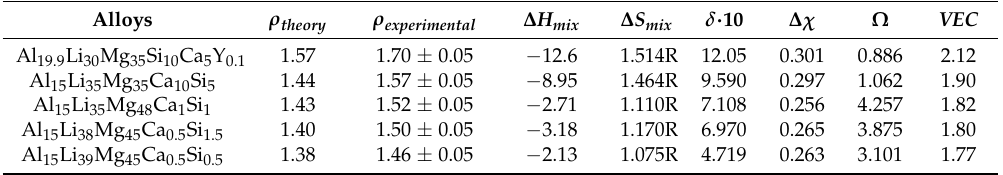
Table 2. Theoretical density of the fabricated alloys and the corresponding calculated values for enthalpy of mixing ( ∆ H mix ), ∆ S mix , atomic size difference ( δ · 10), Pauling electronegativity difference ( ∆ χ ), ratio of entropy to enthalpy values ( Ω ) and valence electron concentration ( VEC ). Alloys ρ theory ρ